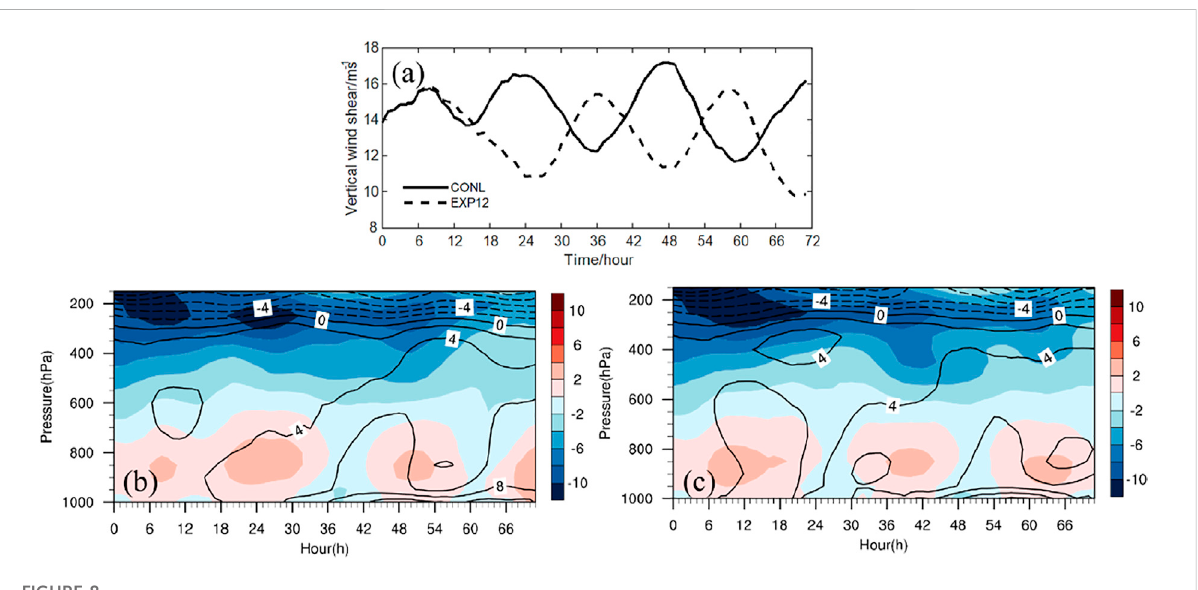
FIGURE 8 (A) Time series and pressure-time pro fi les of the ambient vertical wind shear in the control (B) and sensitivity experiments (C) . “ CONL ” and “ EXP12 ” inFigure8Adenotetheresultsfromthecontrolandsensitivityexperiments,respectively,andthecoloredareasandcontoursinFigures8B,C indicate the ambient zonal wind and meridional wind,